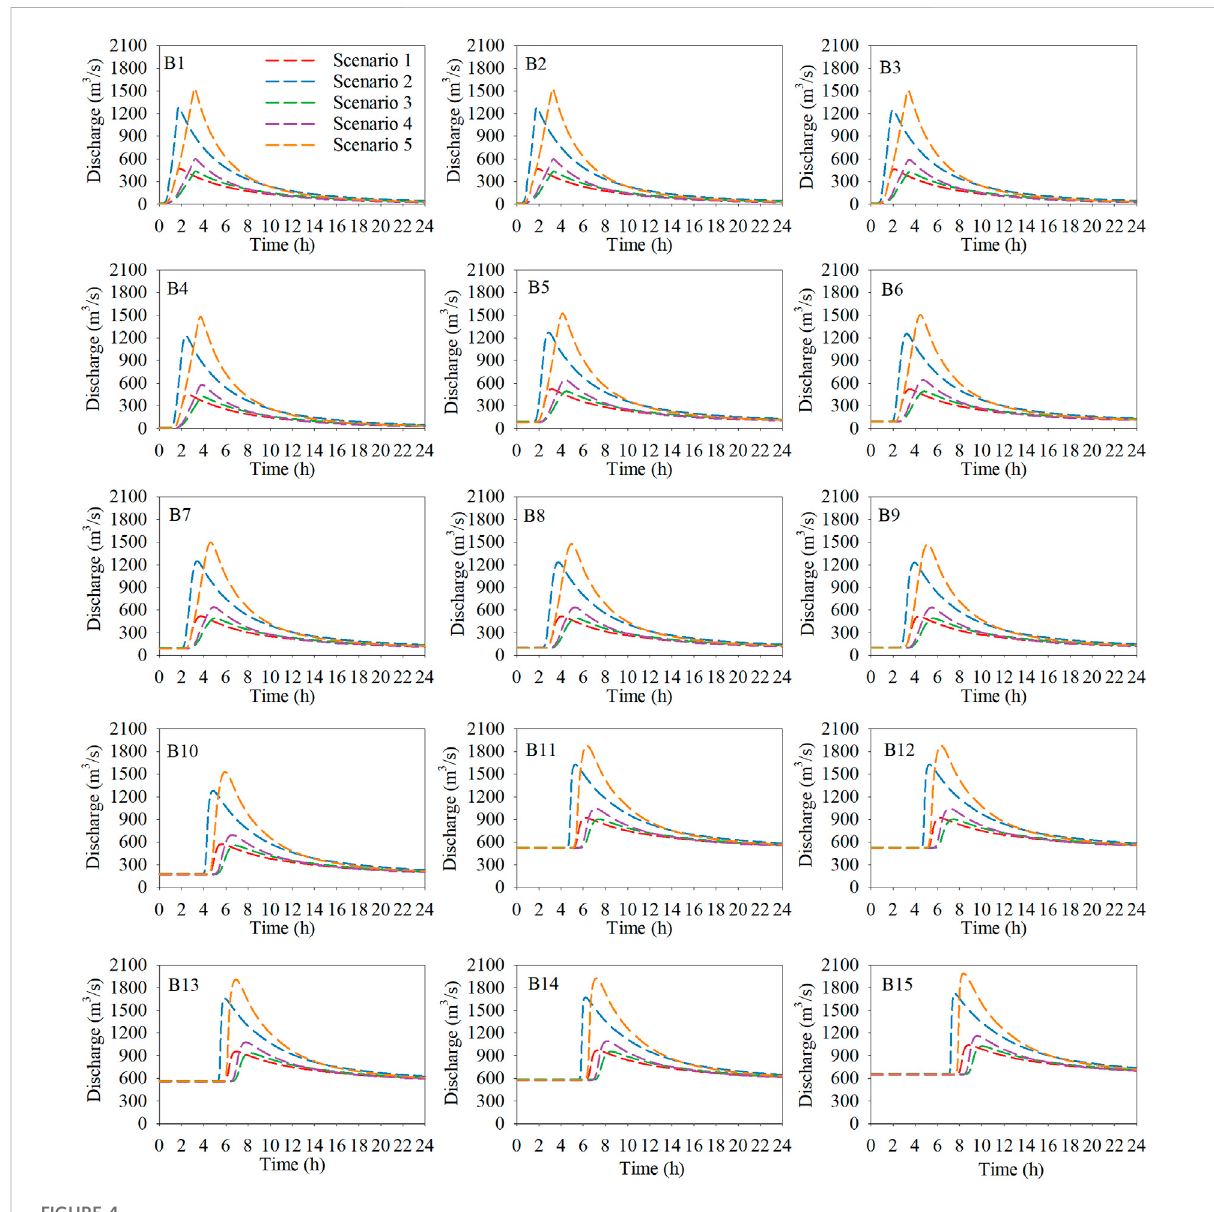
FIGURE 4 GLOF hydrographs of different scenarios at 15 bridge